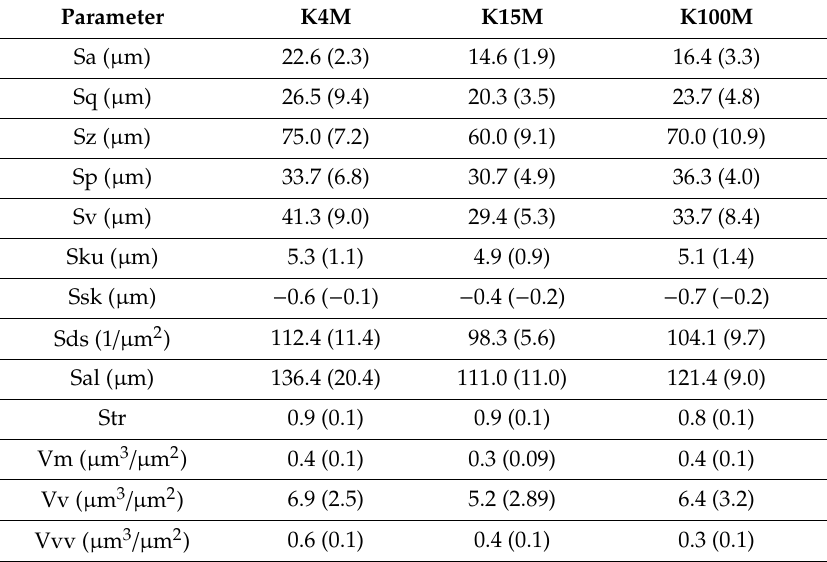
Figure 6. 3D surface texture images ( a ) K4M ( b ) K15M and ( c ) K100M based matrix tablet. Table 5. 3D quantitative surface texture parameters of HPMC / glipizide hydrophilic matrices (n = 10, standard deviations are in